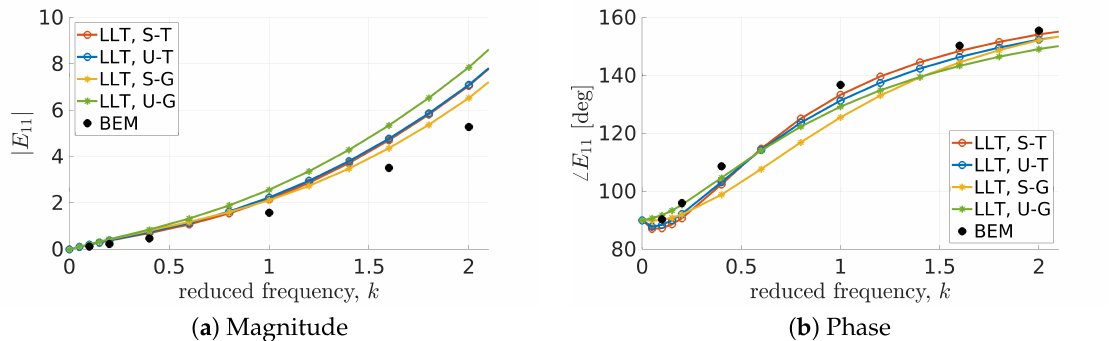
Figure 7. Transfer function E 11 ( k ) , NMV shape functions, l = 2.5m.